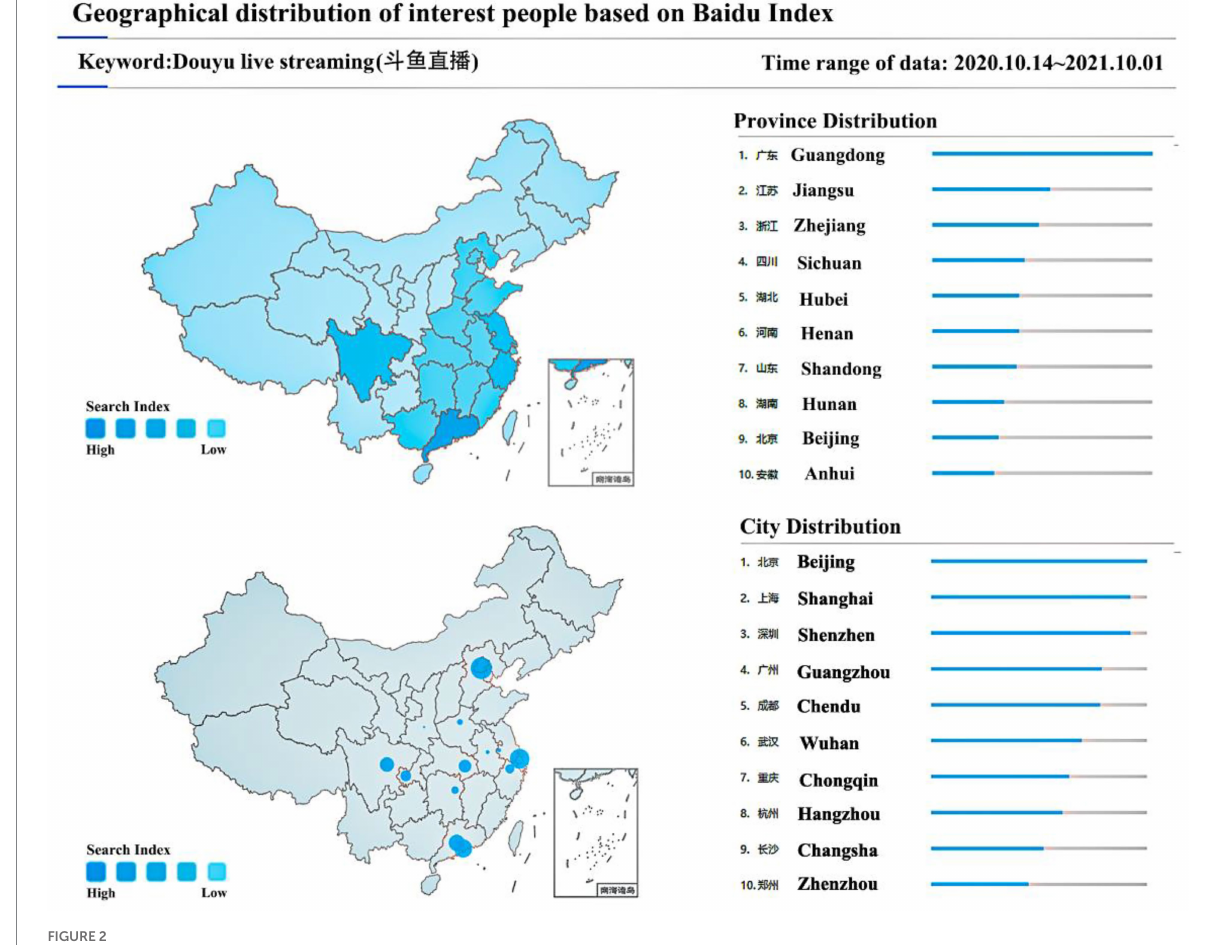
FIGURE 2 Level of attention paid to Douyu live streaming in